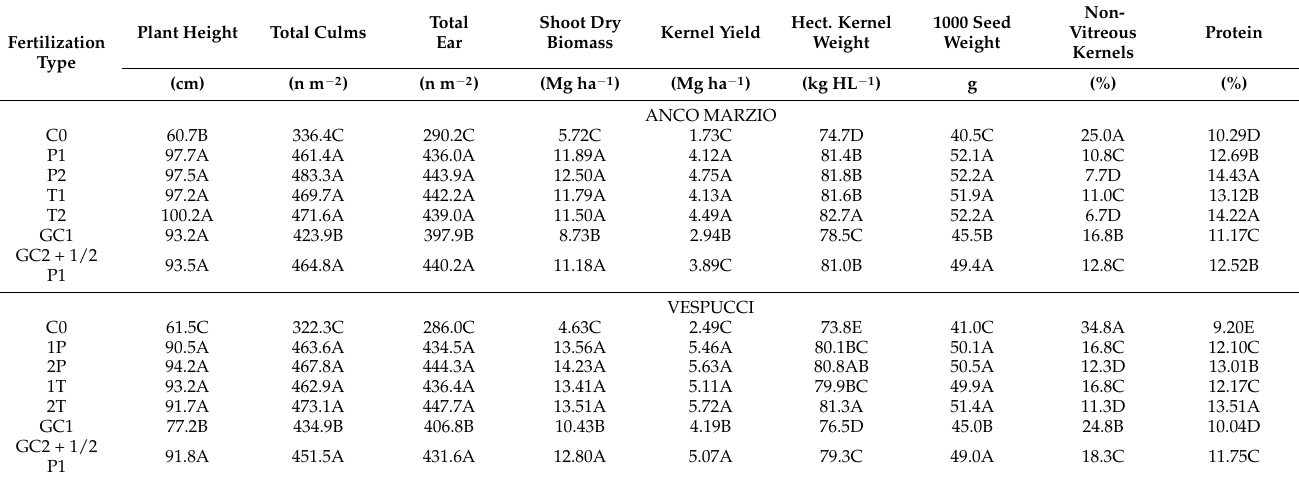
Table 4. Means of values in the years 2019/2020 and 2020/2021 on the morphological, commercial, and physiological parameters in two durum wheat cultivars (Anco Marzio and Vespucci).